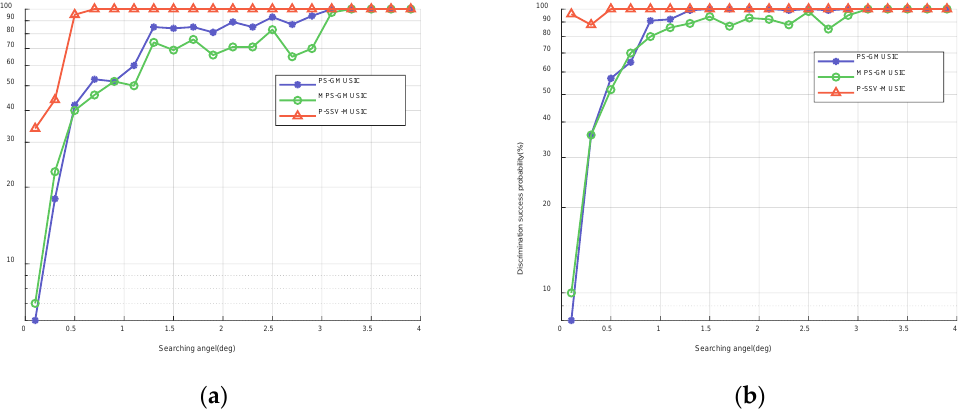
Figure 8. Discrimination success probability with respect to the search angel when T = 100: ( a ) SNR = 15 dB; ( b ) SNR = 20